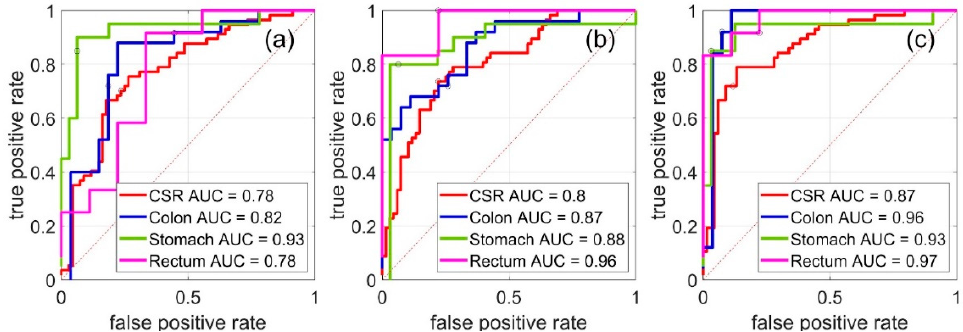
Figure 3. Receiver operating characteristic curve (ROC-curve) of prediction of Leave-one-out (LOO) cross-validation (CV) for models from Table 2. ( a ) Models #1, 4, 7, 10 (models built using NIR data); ( b ) models #2, 5, 8, 11 (models built using MIR data); ( c ) models #3, 6, 9, 12 (models built using concatenated data).